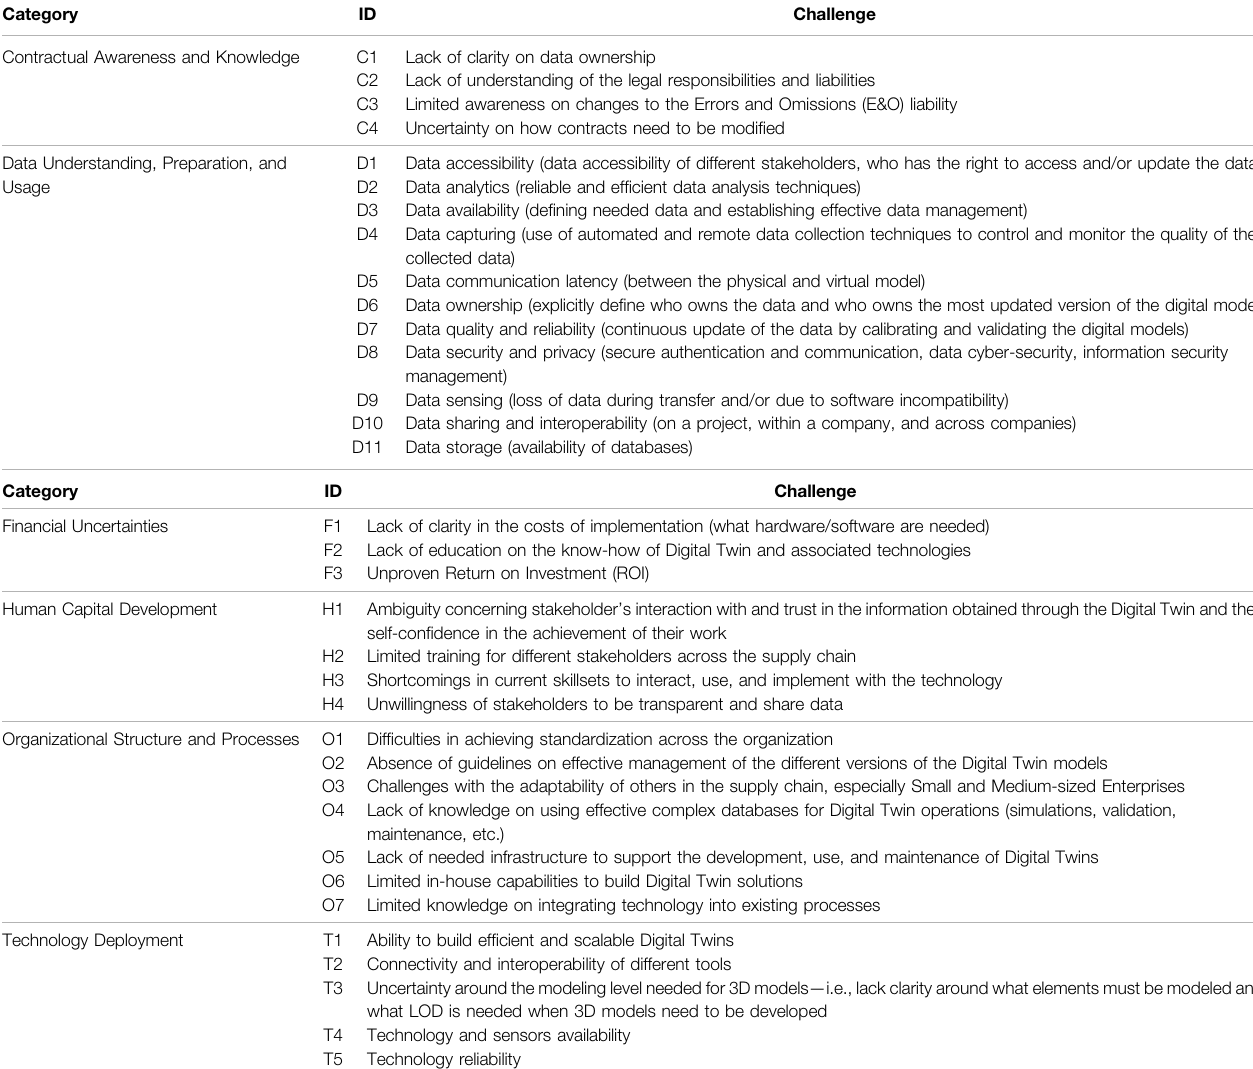
TABLE 10 | Challenges to implementing Digital